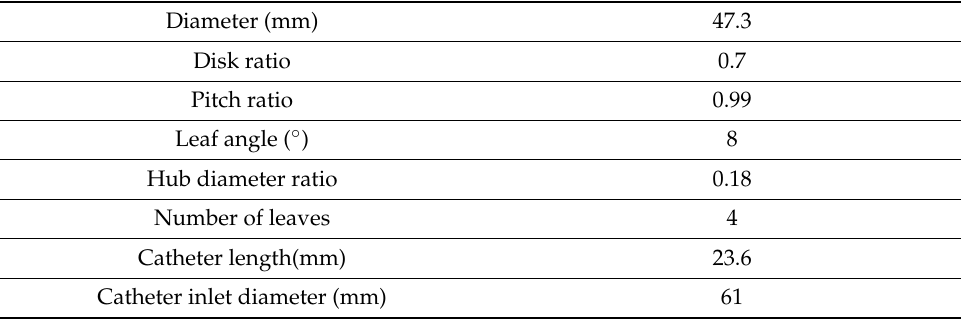
Table 1. Primary parameters of the test ducted